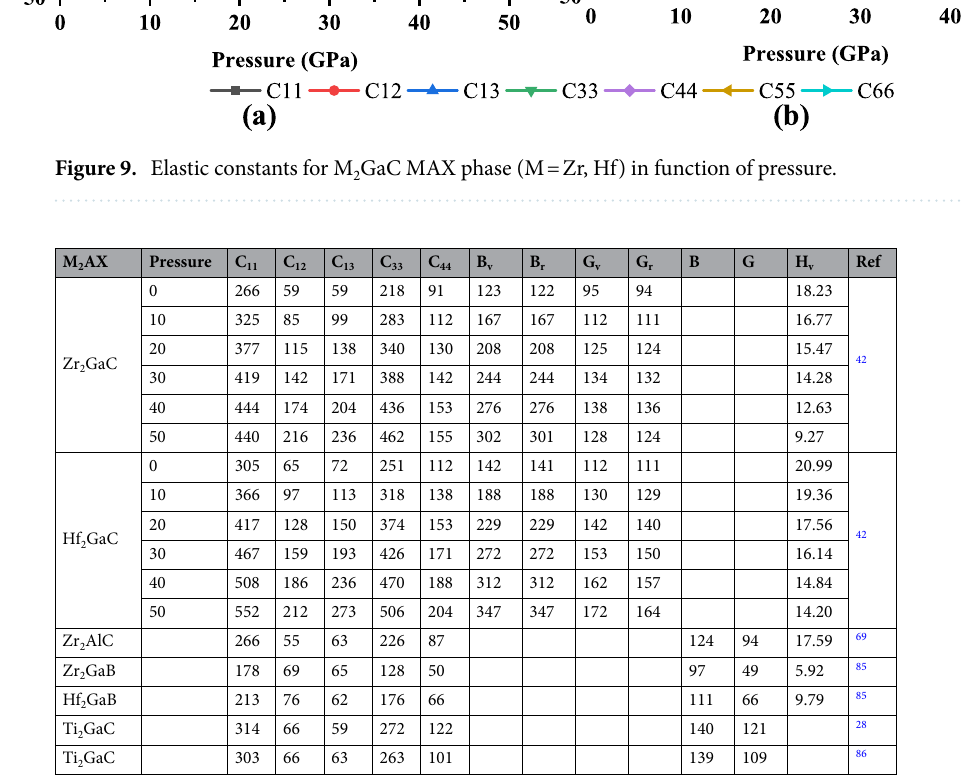
Table 4. Variation of elastic constants and Vickers hardness in GPa for M 2 GaC (M = Zr and Hf) with